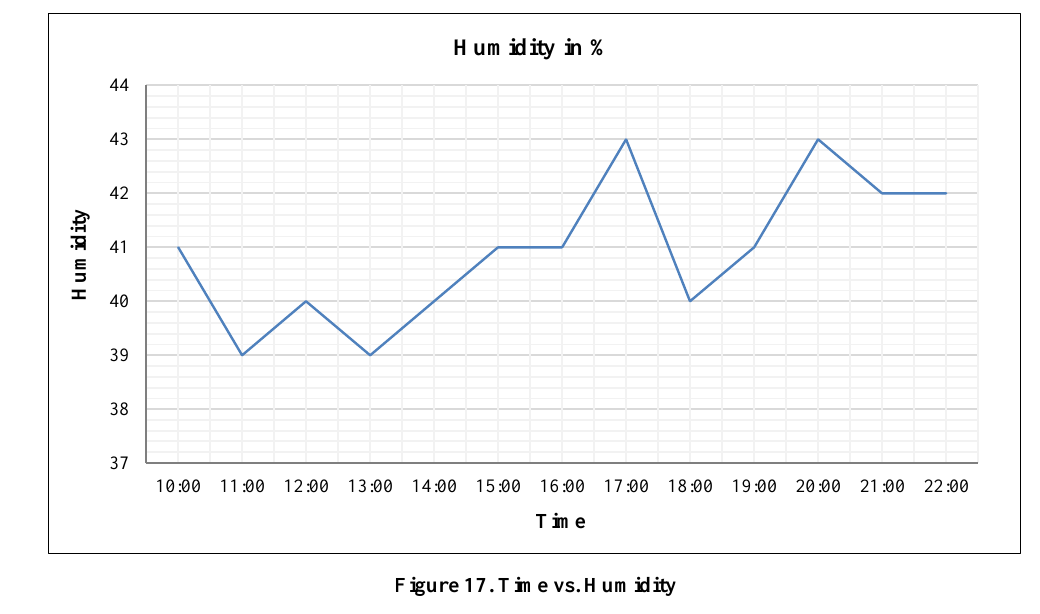
Figure 16. Time vs. Temperature